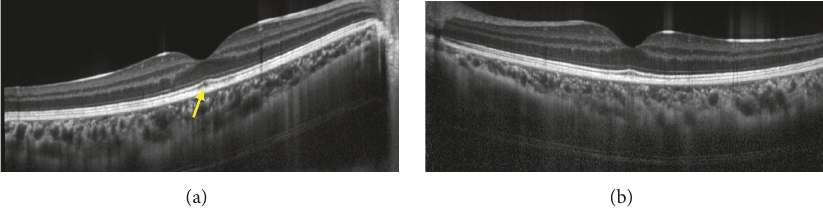
Figure 5: Horizontal EDI-OCT images of the right (a) and left (b) eyes at 2 months after the initial presentation. Subretinal fluid disappeared completely and choroidal thickness recovered within normal range in both eyes. The external limiting membrane and ellipsoid zone (inner/outer segment junction) and retinal pigment epithelium are clearly recognized bilaterally, but there are unclear parts in the interdigitation zone (arrow). The choroidal thickness at the subfovea was 300 𝜇 m in the right eye and 275 𝜇 m in the left